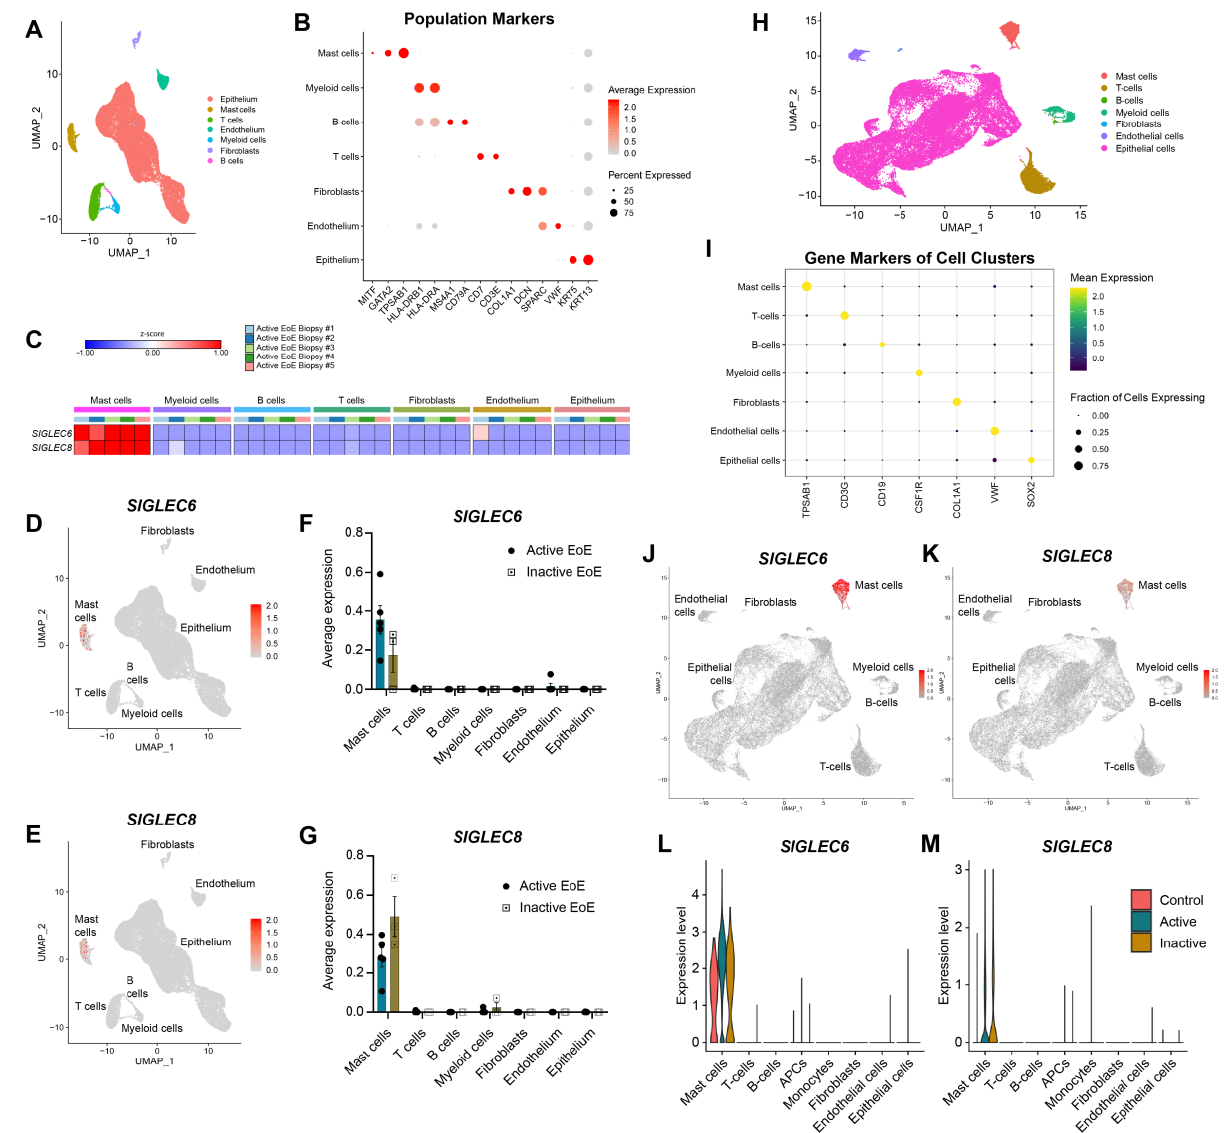
Figure 2. SIGLEC6 expression is restricted to MCs in esophageal tissue biopsies. Gene expression of esophageal cell populations was assessed by single-cell RNAseq from two distinct cohorts at Cincinnati Children’s Hospital Medical Center ( A – G ) and Lurie Children’s Hospital ( H – M ). Results were analyzed using an experimental workflow that led to a uniform manifold approximation and projection (UMAP) plot for dimension reduction displaying 39,562 ( A ) or 44,153 ( H ) single cells. The plots are colored by cell types derived from the shared nearest neighbor (SNN) clustering and enriched marker genes. ( B , I ) Dot plots of marker genes for indicated cell types are shown. ( C ) Heatmap of SIGLEC6 and SIGLEC8 expression level in five donors with active EoE, in which the color for each gene corresponds to the average per-cell gene expression within the given patient in the esophageal cell population. SIGLEC6 expression in all patients is presented in feature plots ( D , J ), average expression by diagnosis is presented in a bar graph ( F ), and expression mean and variance by diagnosis is presented in a violin plot ( L ). SIGLEC8 expression in all patients is presented in feature plots ( E , K ), average expression by diagnosis is presented in a bar graph ( G ), and expression mean and variance by diagnosis is presented in a violin plot ( M ). Cells were isolated from esophageal biopsies derived from patients with active ( n = 5 ( A – G ) or n = 7 ( H – M )) or inactive EoE ( n = 3 ( A – G ) or n = 4 ( H – M )) or a non-EoE control subject ( n = 1 ( H – M